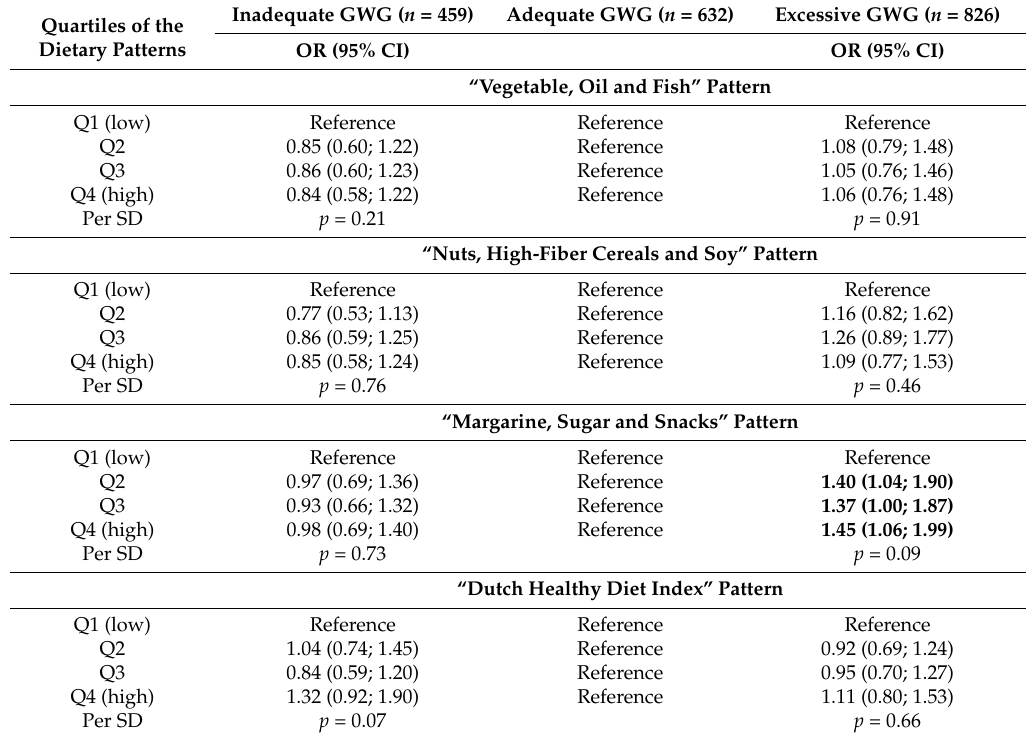
Table 6. Association of dietary patterns with gestational weight gain adequacy ( n = 1917) 1 . Quartiles of the Dietary